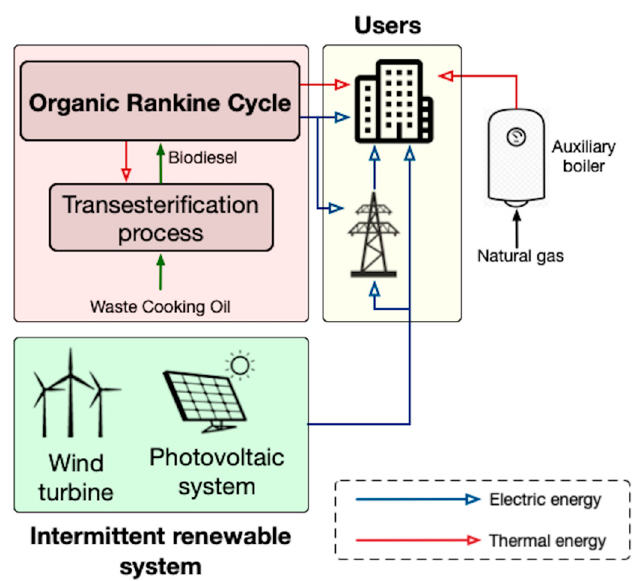
Figure 1. Integrated multi-source system scheme.